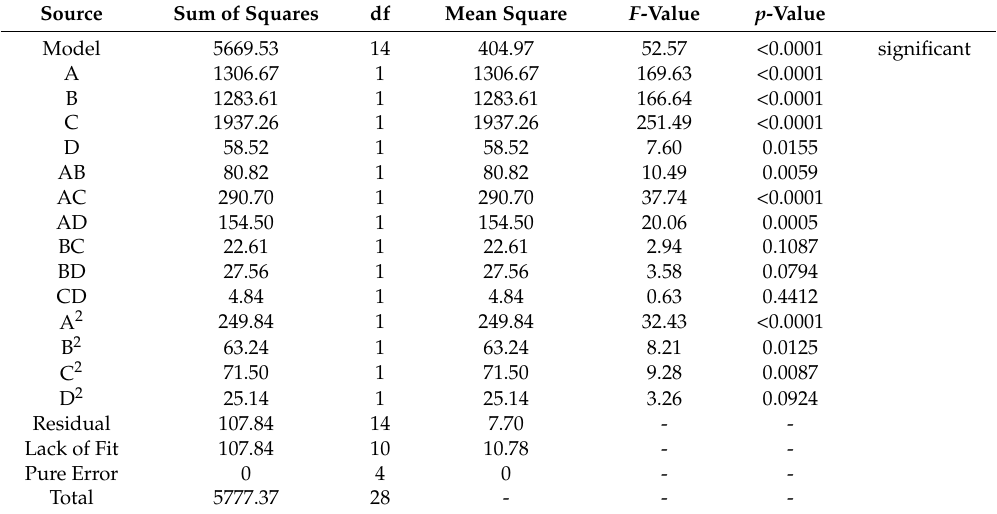
Table 2. Analysis of variance (ANOVA) for the experimental results from the Box–Behnken design (BBD).